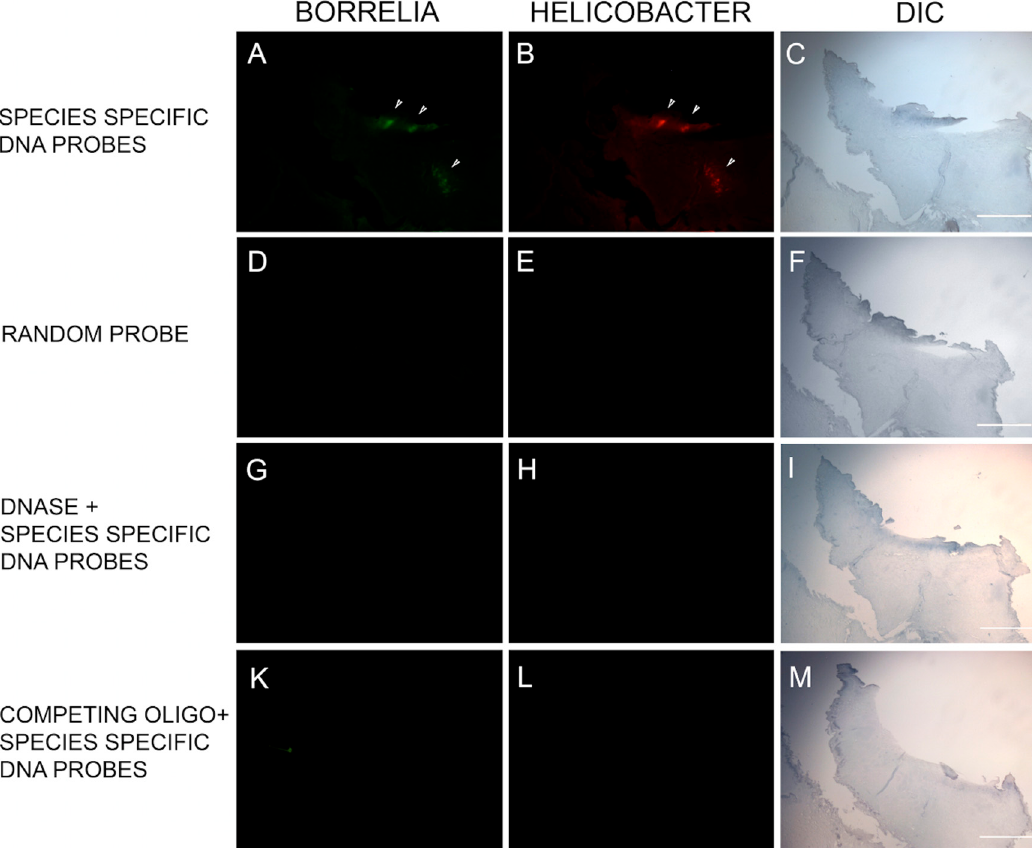
Figure 5. Representative images of the fluorescent in situ hybridization (FISH) reactivity of Helicobacter and Borrelia DNA within an MD skin section. FISH detection was performed as described in the Methods section. Panel A shows reactivity of MD skin sections using a 16s rDNA probe specific for Borrelia burgdorferi (green). Panel B shows reactivity of MD skin sections using a 16s rDNA Helicobacter pylori probe (red). Panels D, E, G, H, K and L show various controls as noted. White arrows indicate positive staining. Panels C, F, I and M show the section imaged with DIC. Images were taken at 100 × magnification. Scale bar = 200 µm.